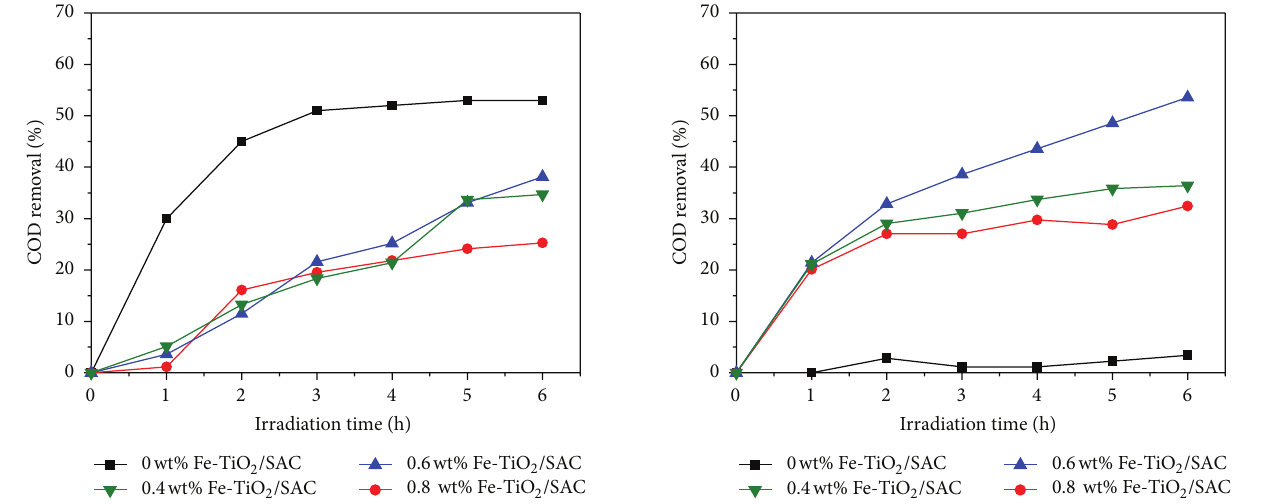
Figure 3: COD removal on the photocatalytic degradation of humic acid by Fe-TiO 2 /SAC under light irradiation with wavelength range of 100 ∼ 280 nm.